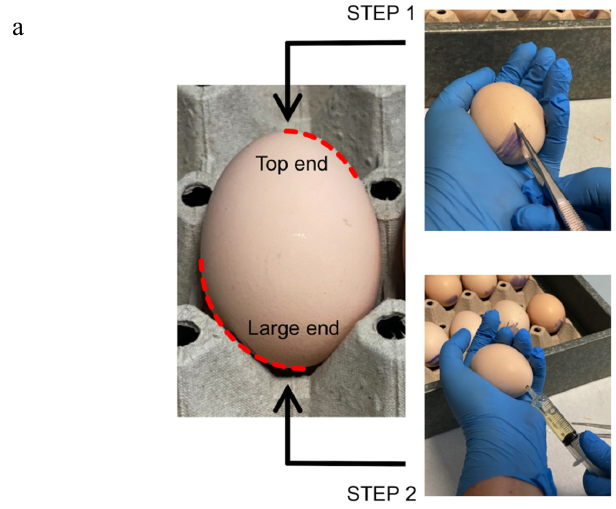
Figure 1. Handling of eggs: ( a ) manipulation of the egg to suck the albumen; ( b ) opening of the shell, exposure of the chorioallantoic membrane (CAM) for the implants, and closing with tape.